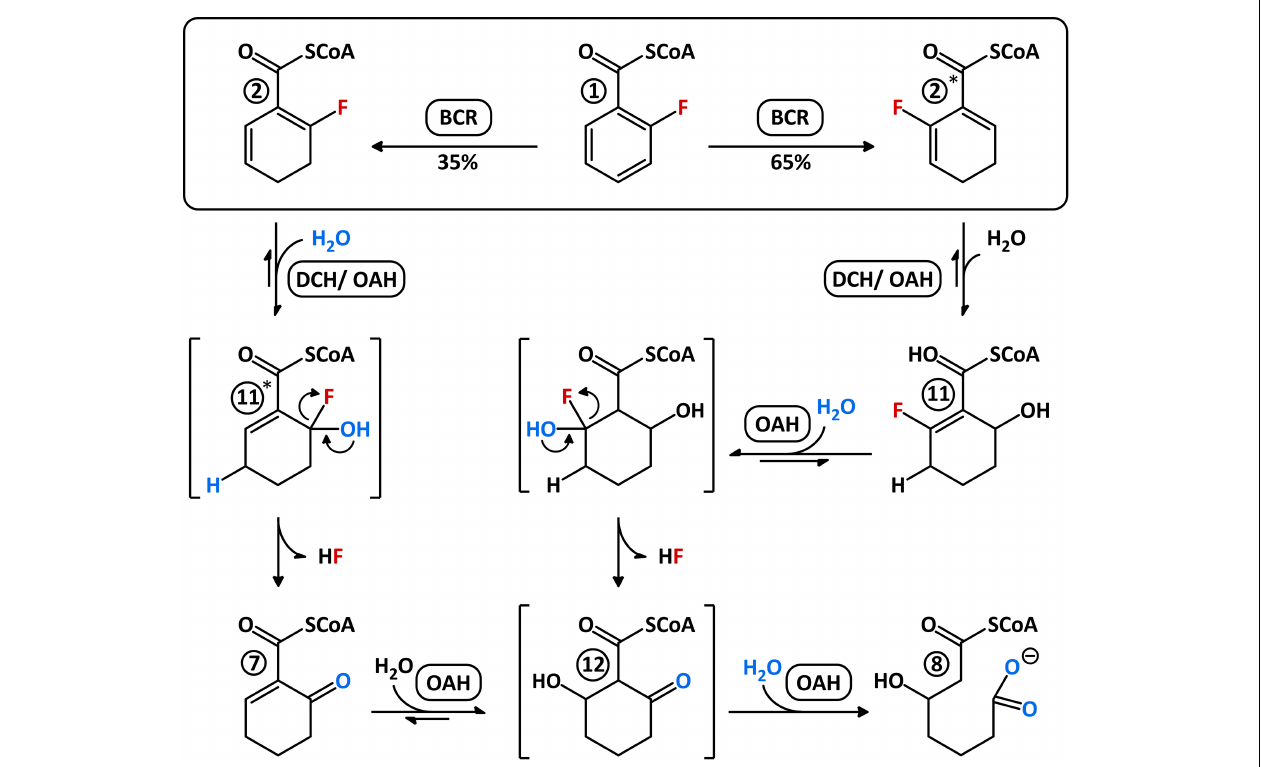
FIGURE 7 | Possible mechanism for the conversion of 2-F-BzCoA by BCR, DCH, and OAH. Both F-1,5-dienoyl-CoA isomers (compounds 2/2 ∗ ) are hydrated to different F-OH-1-enoyl-CoA isomers (compounds 11/11 ∗ ) by DCH and OAH, likewise. Unstable 6-F-6-OH-1-enoyl-CoA (11 ∗ ) spontaneously decomposes to 6-oxo-1-enoyl-CoA (compound 7) by HF-expulsion. This, in the presence of OAH, becomes immediately hydrated presumably to 2-oxo-6-OH-cyclohexanoyl-CoA (compound 12) before hydrolysis to 3-OH-pimeloyl-CoA (compound 8). Stable 2-F-6-OH-1-enoyl-CoA (compound 11) can also only be further hydrated by OAH,